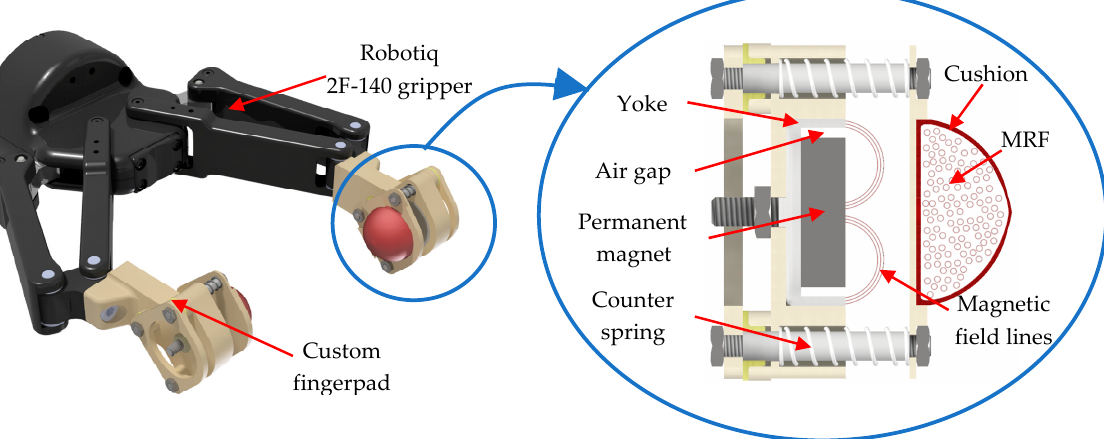
Figure 2. Research object, i.e., Robotiq 2F-140 gripper equipped with the cross section of a custom MRF cushion fingerpad.